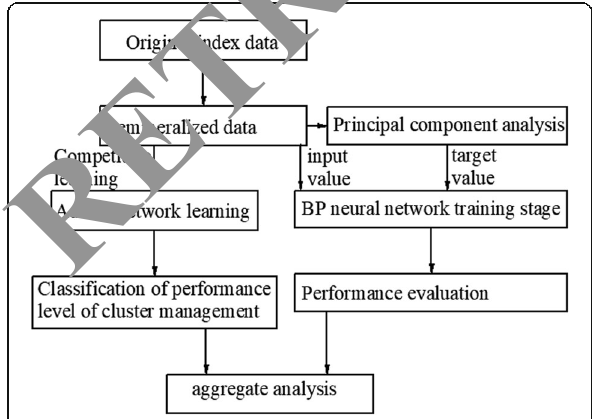
Fig. 2 Construction of performance evaluation model for industrial cluster management of small- and medium-sized enterprises based on BP neural network algorithm Fig. 3 BP neural network training